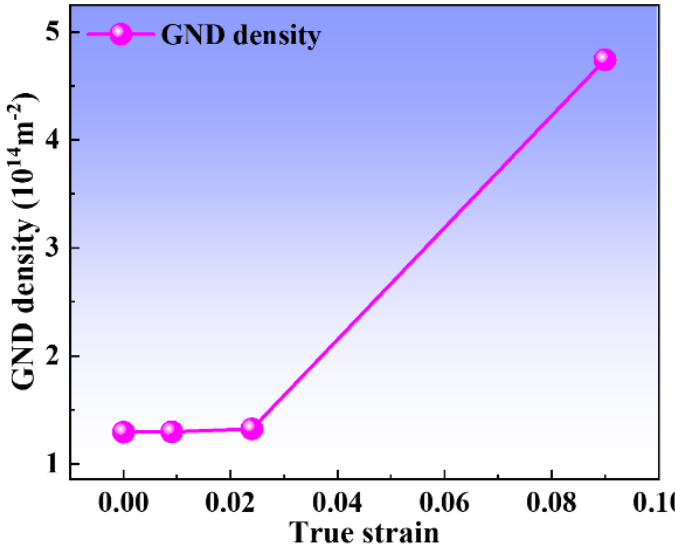
Figure 7. The evolution of geometrically necessary dislocation (GND) densities at different true strains.